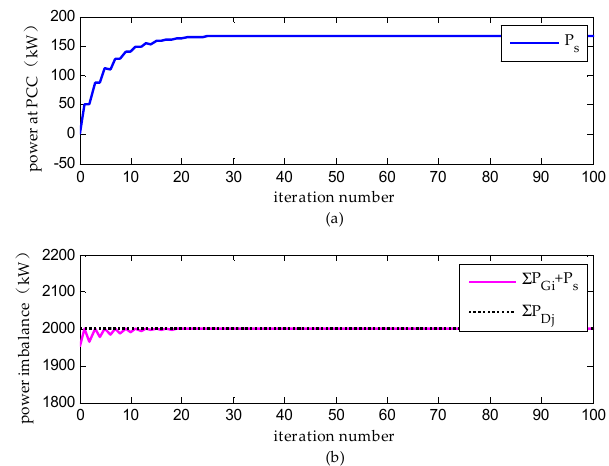
Figure 4. The simulation of power balance in Scenario A. ( a ) Power at PCC; and ( b ) The variation of power imbalance.